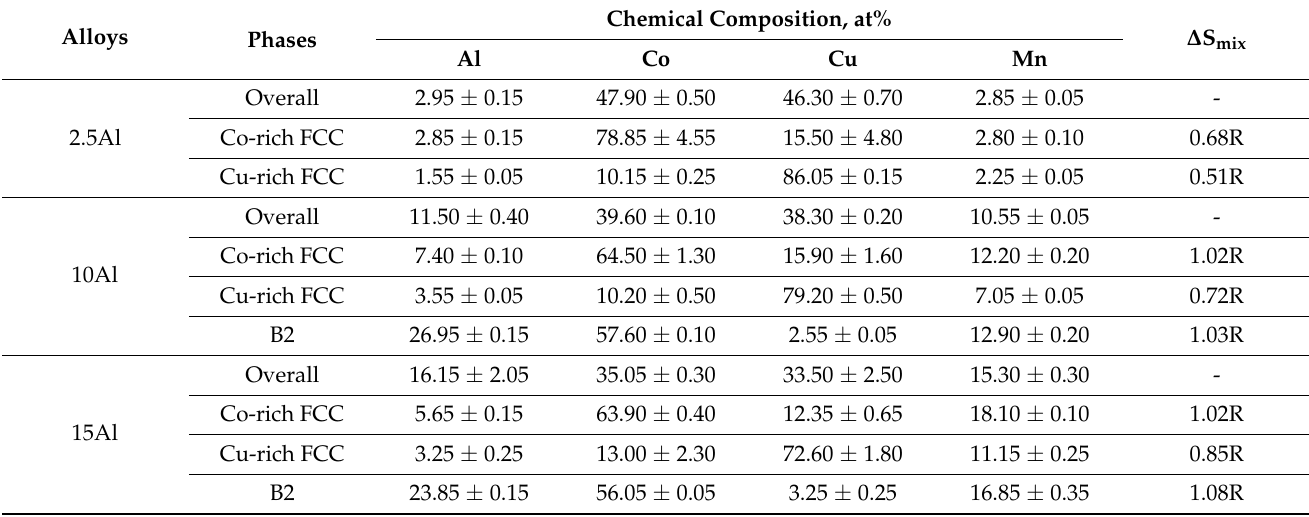
Table 1. The averaged chemical compositions with standard deviations and configurational entropy of the dual FCC and B2 phases in the 2.5Al, 10Al, and 15Al alloys obtained by EDS.